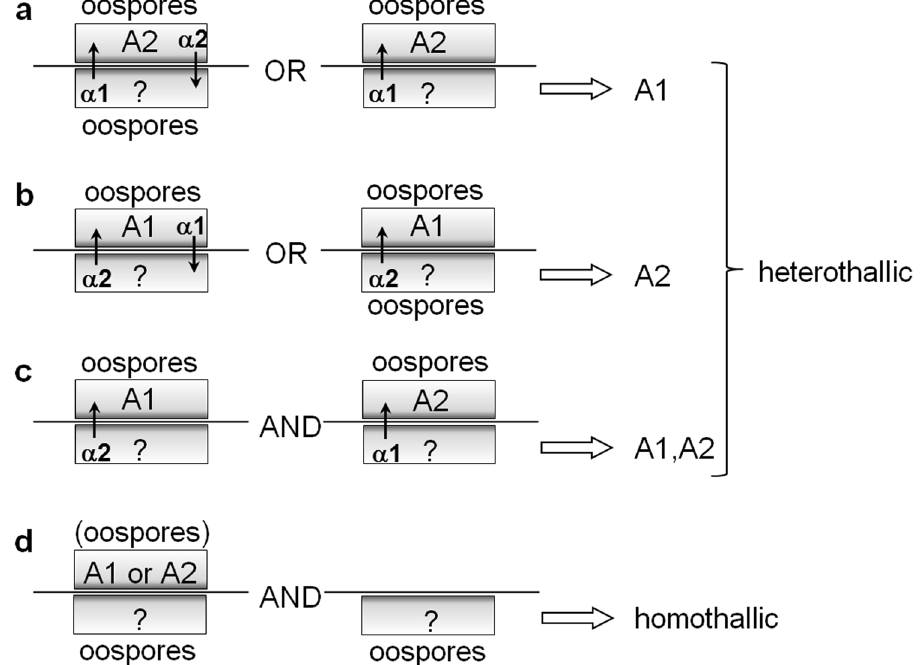
Figure 2. Evaluation of the mating types of Phytophthora . The evaluation is based on the hormone production/ reception experiment reported previously 11 . A tested strain (down) was paired with the tester strain (up) P. nicotianae American Type Culture Collection (ATCC) 38607 (A1 mating type) or ATCC 38606 (A2) on the opposite side of a polycarbonate membrane (horizontal bars) to avoid direct hyphal contact. ( a ) The strains that induced the oospores of the A2 tester were assigned as A1, which may or may not produce oospores in response to the A2 tester. ( b ) The strains that induced the oospores of the A1 tester were assigned as A2, which may or may not produce oospores in response to the A1 tester. ( c ) The strains that formed no oospores but induced oospores in both the A1 and A2 testers were designated as A1,A2. ( d ) The strains that produced oospores in the presence and absence of a tester strain were assigned as homothallic species, which may or may not induce oospores in the tester